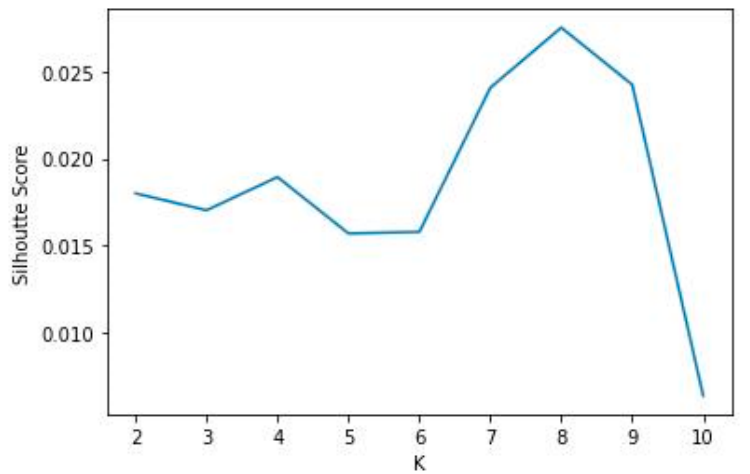
Figure 5. Contour coefficient and K value.